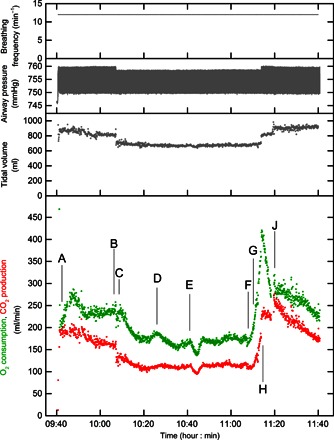
Gas exchange measurements during repair of an abdominal aortic aneurysm.Breathing frequency, airway pressure, tidal volume, oxygen consumption, and carbon dioxide production during elective repair of an abdominal aortic aneurysm. Oxygen consumption and carbon dioxide production are shown breath-by-breath, rather than as the continuous integral of Fig. 3. Events are represented by points as follows: (A) knife to skin; (B) reduction in ventilator driving pressure; (C) aortic clamp applied; (D) fall in blood pressure; (E) metaraminol (fast-acting α-agonist) bolus, and infusion rate increased from 2 to 5 ml/hour; (F) and (G) sequential removal of iliac artery clamps; (H) increase in ventilator driving pressure; and (J) removal of superior retractor restricting rib cage movement.